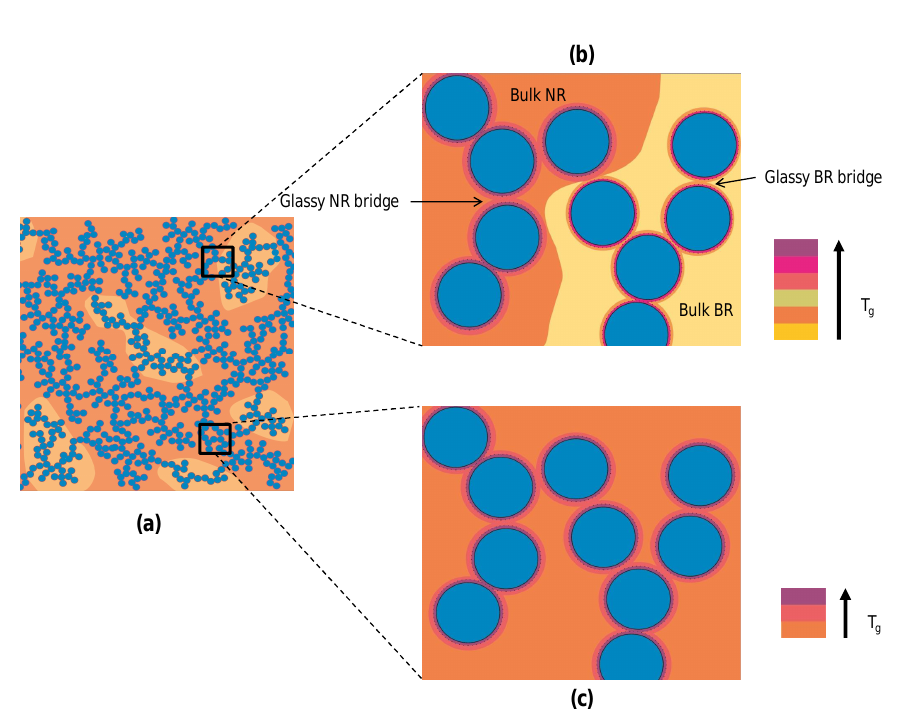
Figure 8. Schematic showing ( a ) viscoelastic filler network in a CB filled NR-BR blend. ( b ) Zoom on particles in filler network connected by NR and BR glassy bridges that soften several 10K higher than the bulk T g of respective matrix as indicated by the color code and ( c ) corresponding situation in a pure NR